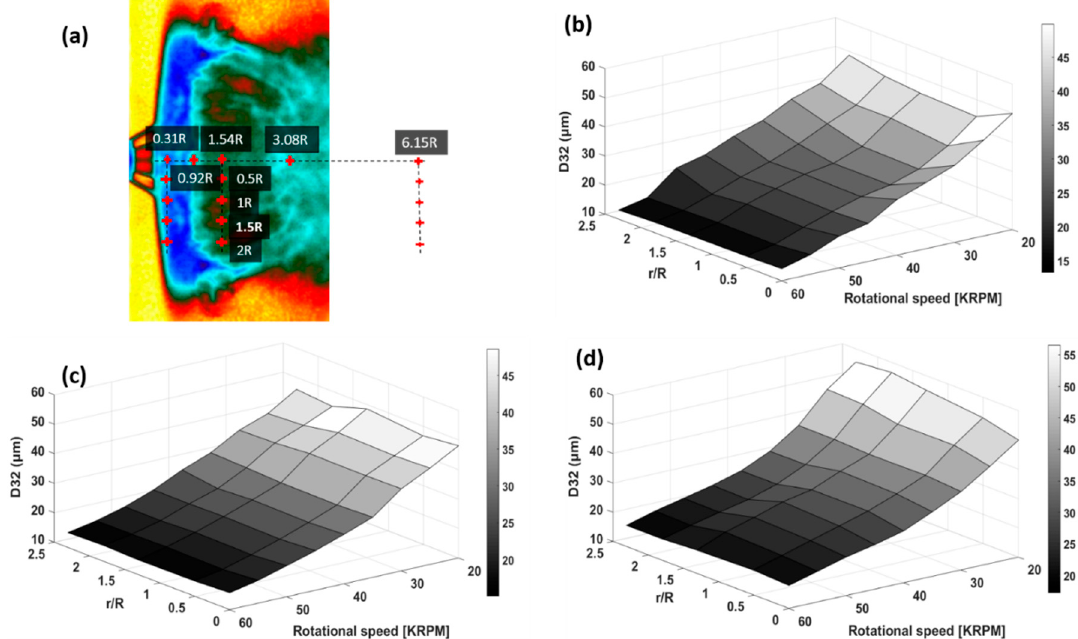
Figure 7. The variation of the D 32 for a fluid flow rate of 250 ccm and varying the rotational speed of the ERBS at different vertical locations within the spray flow field.